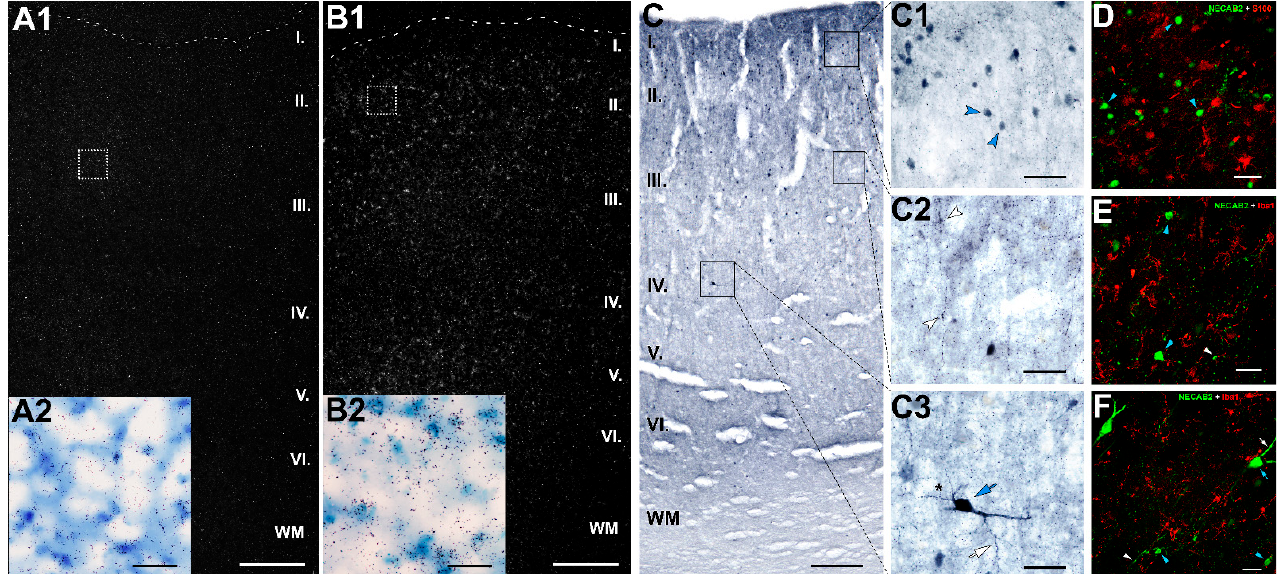
Figure 7. Characterization of NECAB2-immunoreactive (NECAB2-ir) neurons in the DMPFC. ( A , B ) NECAB2 mRNA expression in the DMPFC of control ( A1 ) and suicide ( B1 ) individuals were visualized by in situ hybridization histochemistry. A dark-field photomicrograph shows high intensity of NECAB2 hybridization signal in the DMPFC. NECAB2 signal is prominent in cortical layers II and IV in the DMPFC of suicide victims ( B1 ) compared to the representative control ( A1 ). High magnification bright-field microphotographs of tissue sections ( A2 , B2 ) show the area assigned by the dashed boxes in ( A1 , B1 ) and developed for silver grains in the control ( A2 ) and suicide ( B2 ) victims. Cortical layers are indicated on the left. ( C ) Laminar distribution of NECAB2-ir neurons across cortical layers in the left DMPFC of a female control individual (62 years old) visualized by DAB immunostaining. NECAB2-ir neurons are mainly located in II–V layers and as shown on ( C1 , C3 ), NECAB2 is located in at least 2 different interneuron subtypes based on the shape and size of labeled neurons. ( C1 – C3 ) Higher magnification of the boxed area in ( C ). ( C1 ) NECAB2-ir neurons are presented in cortical layer II of the DMPFC (blue arrowhead). ( C2 ) NECAB2-ir axons give rise to varicosities (white arrowheads) along the section. ( C3 ) A higher magnification photomicrograph of a layer IV NECAB2-immunopositive interneuron shows the soma (blue arrow), the varicose den- dritic tree (asterisk) and a part of the axon (white arrow). Cortical layers are indicated on the left. ( D – F ) Representative confocal microscopy images of double immunolabeling of Iba1 and S100B glial markers (red) with NECAB2 (green) in DMPFC control sections. ( D ) High-magnification confocal image of a section double-labeled with S100B (red) indicates that NECAB2 (green) does not colocalize with S100-positive astrocytes. ( E , F ) Likewise, NECAB2-positive cells and Iba1-positive microglia do not have overlapping distributions. Scale bar represents 500 µ m in ( A1 , B1 ), 250 µ m in ( C ), and 50 µ m in ( A2,B2 , C1 – C3 , D – F ). Abbreviations: I-VI–cortical layers; WM–white